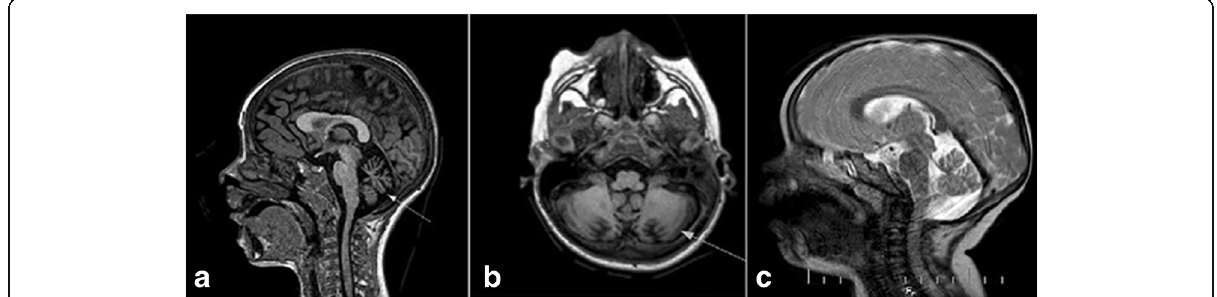
Fig. 1 Patient A. Follow-up MRI at 47 months: a ) Sagittal T1-weighted image showing cerebellar atrophy (arrow); b ) Axial FLAIR image showing hyperintensity of cerebellar white matter and dentate nuclei (arrow). Patient B. MRI at 24 months: c ) Sagittal T2-weighted image showing megacisterna magna and atrophy of